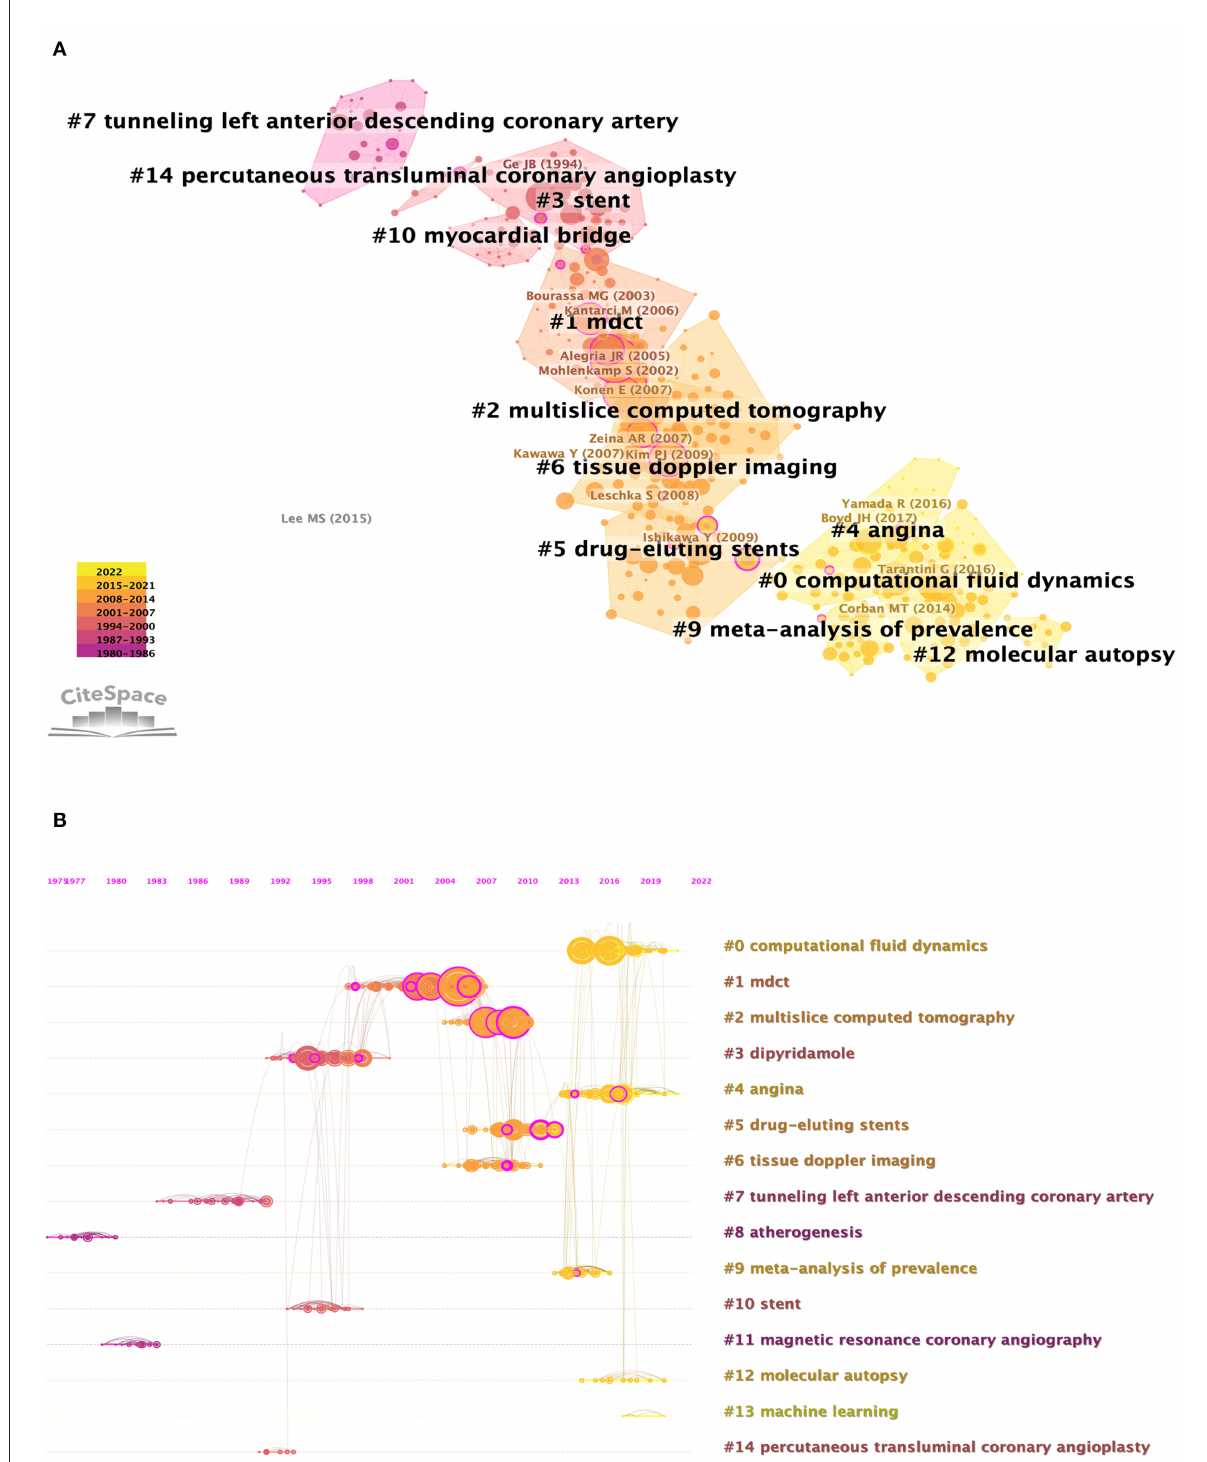
FIGURE7 Analysis of co-citation references in the field of the myocardial bridge. (A) The network map of co-citation clusters. Fourteen clusters with different research topics were formed, reflecting in different colors on the map. (B) The timeline view of co-citation clusters. Each horizontal row represented a cluster, and each node presented by a “tree ring” on the line represented a study. The line between the nodes reflected the co-citation relationship between the two studies, and the size of the node meant the number of co-cited times. Cluster #0 computational fluid dynamics, #4 angina, #9 meta-analysis of prevalence, #12 molecular autopsy, and #13 machine learning were the most recent research